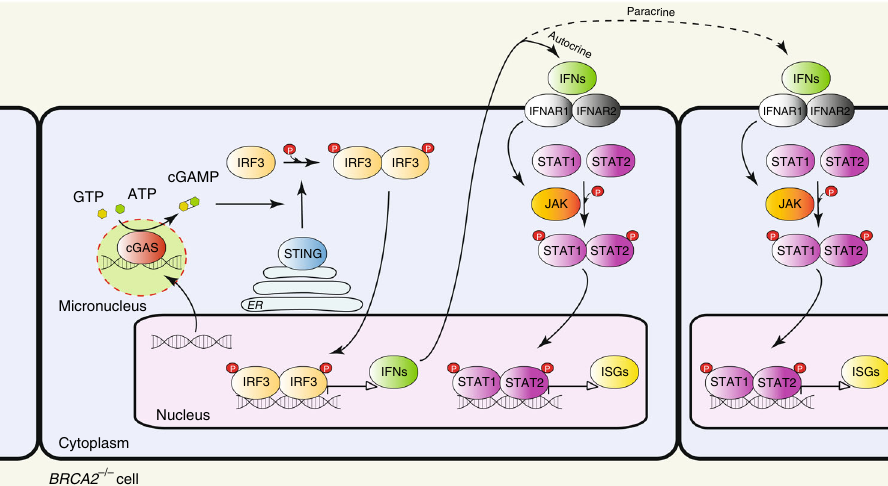
Fig. 7 Model of innate immune response activation in BRCA2-de fi cient cells. Intrinsic replication stress and unrepaired DSBs cause genomic instability leading to release of DNA into the cytosol. Cytosolic DNA assembles into micronuclei, where it binds to and activates cyclic GMP-AMP synthase (cGAS), a cytosolic DNA sensor. cGAS catalyzes the synthesis of cyclic GMP-AMP (cGAMP), which binds to and activates STING (stimulator of interferon genes). STING promotes TBK1-dependent phosphorylation of interferon response factor 3 (IRF3), which translocates into the nucleus as a homodimer to induce transcription of type I interferon. Secreted interferon binds to transmembrane receptors and elicits autocrine and paracrine signaling, both mediated by the JAK-STAT pathway. Janus kinases (JAKs) phosphorylate signal transducer and activator of transcription 1 (STAT1) and 2 (STAT2), which enter the nucleus as a heterodimer to initiate transcription of interferon-stimulated genes (ISGs). ER, endoplasmic